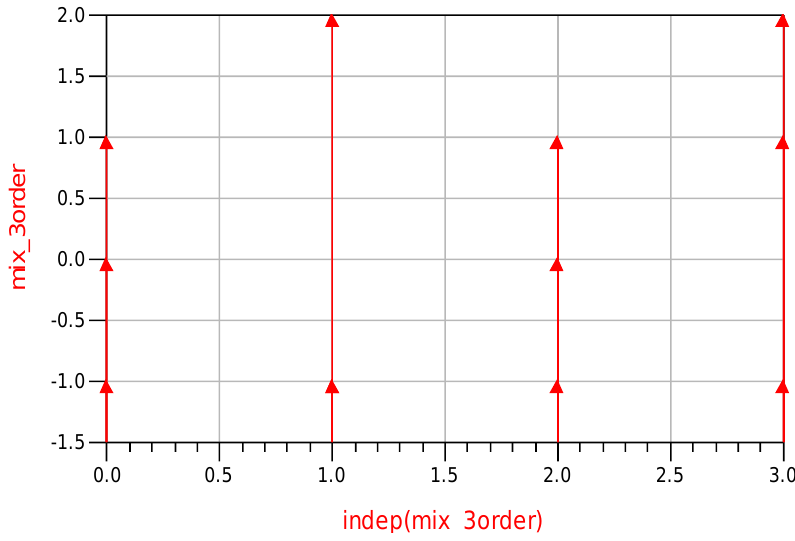
Figure 12. Harmonic Differential Third-order.